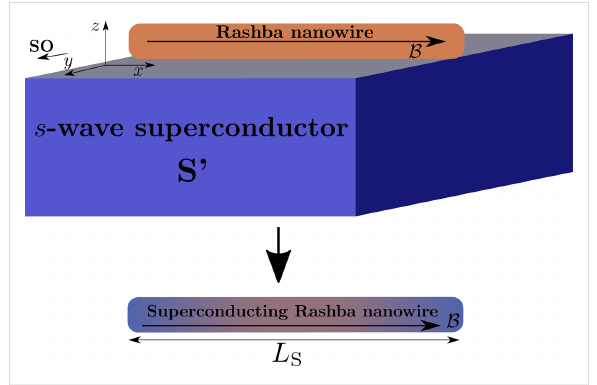
Figure 1: A semiconducting nanowire with Rashba SOC is placed on a s -wave superconductor (S’) with pairing potential Δ S ′ and it is subject- ed to an external magnetic